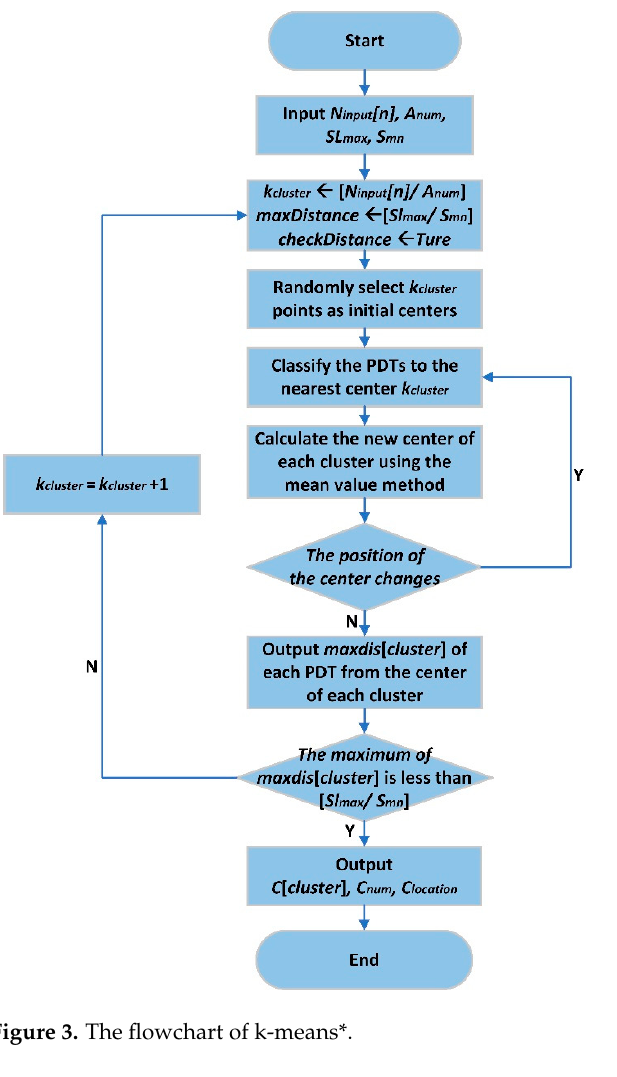
Figure 3. The flowchart of k-means*.